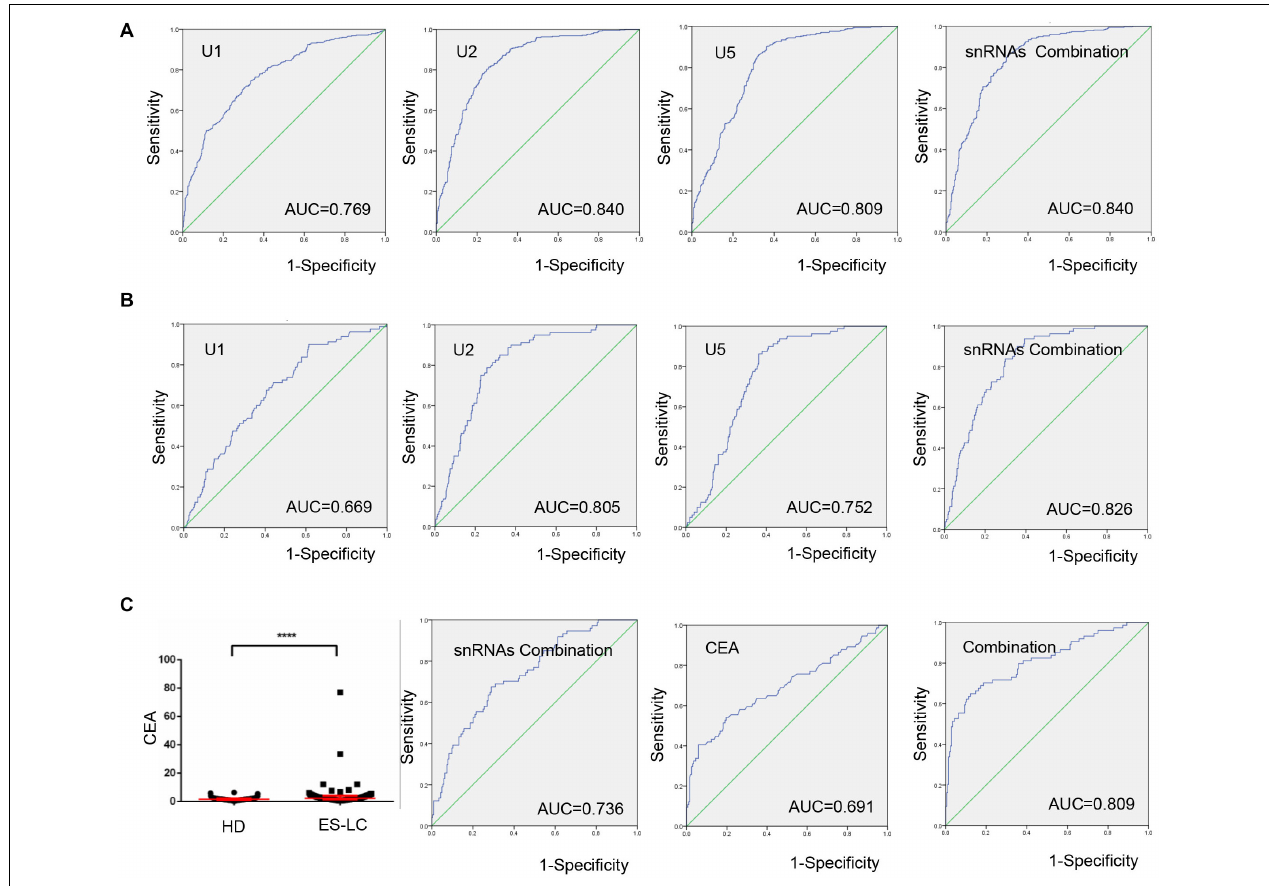
FIGURE 3 | TEP U1, U2 and U5 as biomarkers for lung cancer diagnosis. (A) The ROC curve analysis of U1, U2, U5 and their combination for lung cancer; (B) The ROC curve analysis of U1, U2, U5 and their combination for early stage lung cancer; (C) The levels of CEA were increased in early stage lung cancer patients ( n = 74) compared with healthy controls ( n = 204). The ROC curve analysis of snRNAs combination, CEA and the combination of snRNAs and CEA (AUC = 0.809) for early stage lung cancer. AUC, area under curve; **** P <